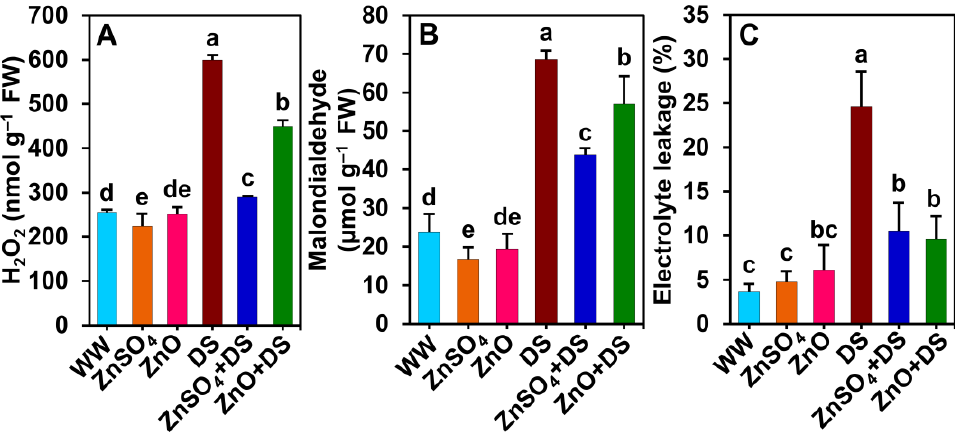
Figure 4. Effect of separately applied ZnSO 4 (1.0 g Kg − 1 soil) and ZnO (1.0 g Kg − 1 soil) on ( A ) hydrogen peroxide (H 2 O 2 ), ( B ) malondialdehyde, and ( C ) electrolyte leakage levels in the leaves of cotton plants that were subjected to water deprivation-induced drought stress for 6 days. The means and standard deviations ( n = 3) are displayed as bars. Significant changes ( p < 0.05) among the treatments are denoted by different letters (a–e) above the bars as calculated using the least significant difference test. Here, the treatments are well-watered plants (WW), ZnSO 4 -supplemented well-watered plants (ZnSO 4 ), ZnO-supplemented well-watered plants (ZnO), drought-stressed plants (DS), ZnSO 4 -supplemented drought-stressed plants (ZnSO 4 + DS), and ZnO-supplemented drought- stressed plants (ZnO + DS). FW, fresh weight.